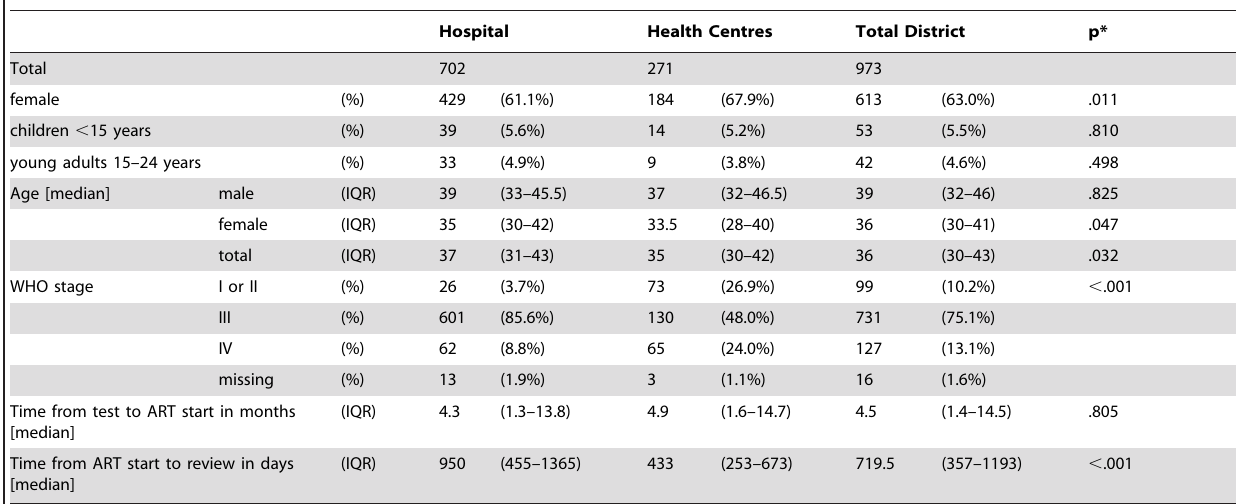
Table 2. ART patient characteristics.